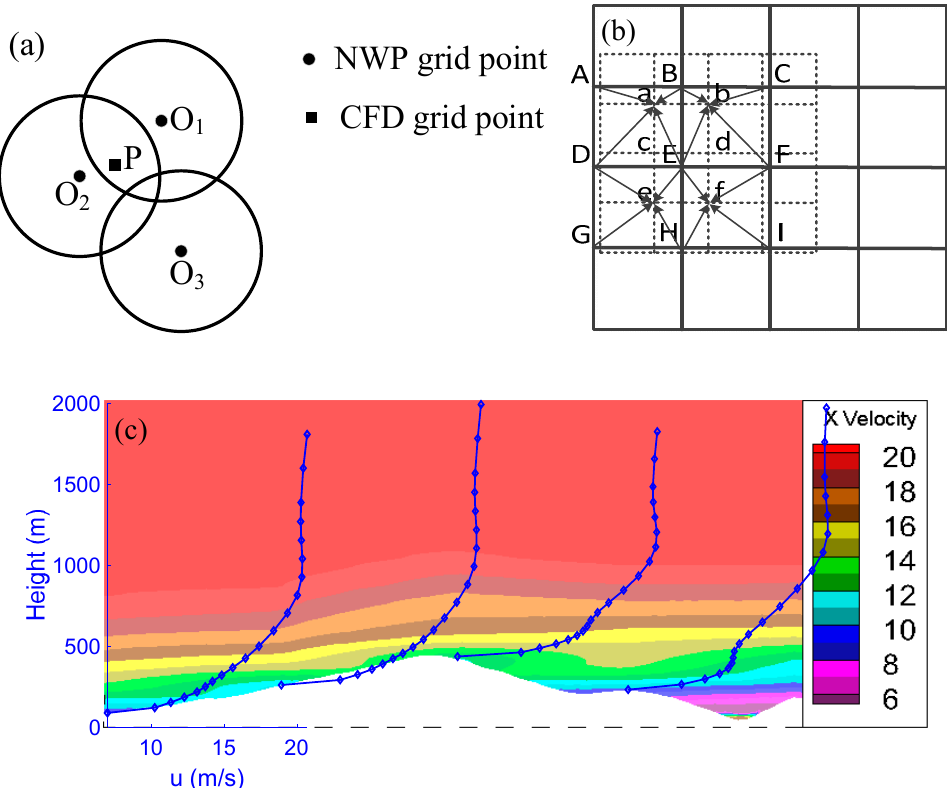
Figure 4. Cressman interpolation method: ( a ) sketch map of Cressman interpolation; ( b ) sketch map of imposing NWP grid points on a CFD boundary, A–I represent NWP grid points, a–f represent CFD grid points; ( c ) the u component (m/s) of the CFD wind speed on the western boundary of the CFD domain. On the boundary, the horizontal axis represents width (0–4 km) of the CFD domain, and the vertical axis represents height (0–2 km). Using Cressman interpolation, five NWP wind profiles at 0 km, 1 km, 2 km, 3 km, and 4 km on the horizontal axis (blue curves) were interpolated on the CFD boundary.